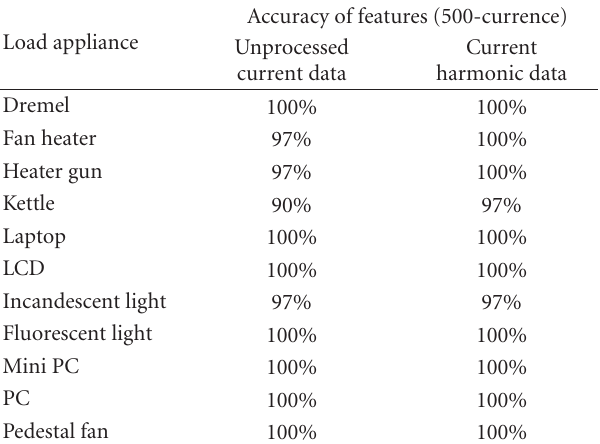
Table 3: Results of 11 loads